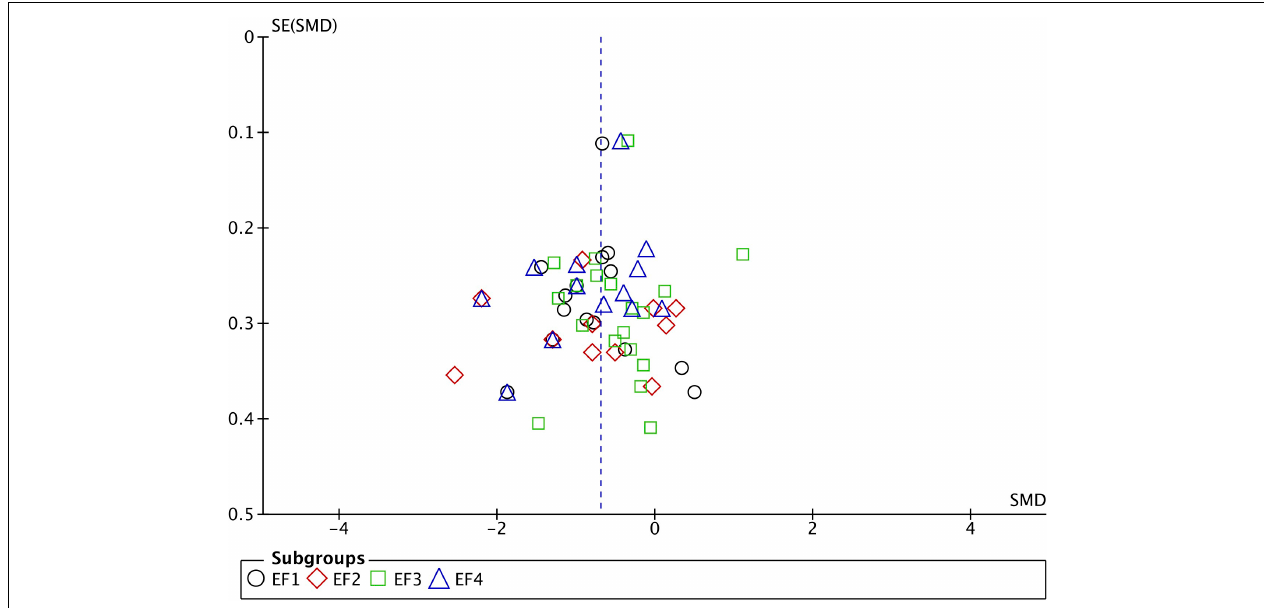
FIGURE 1 | Funnel plot of studies comparing Executive Function performance between ASD and TD. SMD, standard mean difference (Effect Size); SE, standard error; EF1, inhibition; EF2, working memory; EF3, flexibility; EF4, planning. Positive effect sizes indicate superior performance in ASD. The solid vertical line indicates the estimate for the population effect